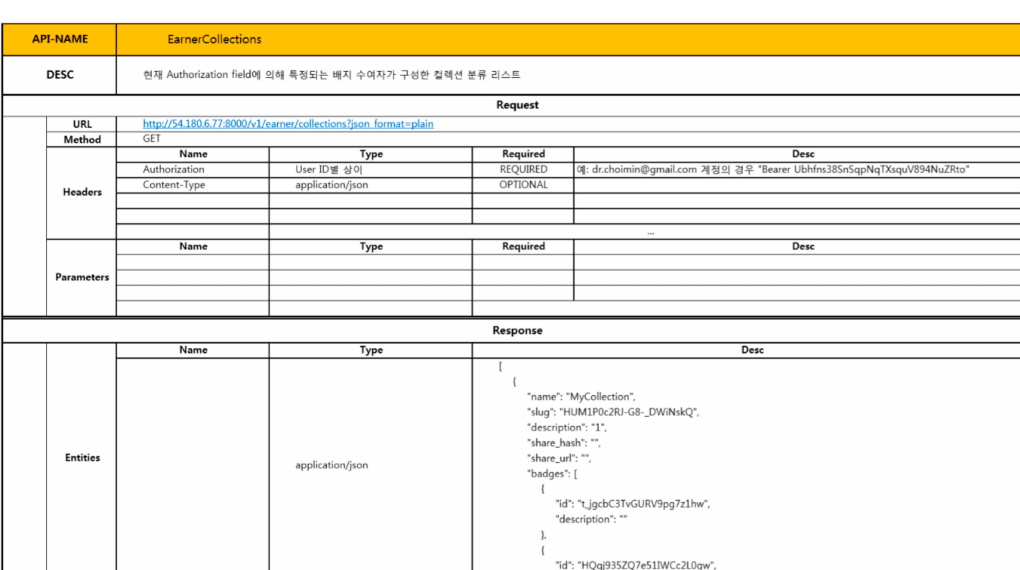
Figure 11. REST API for creating badge.